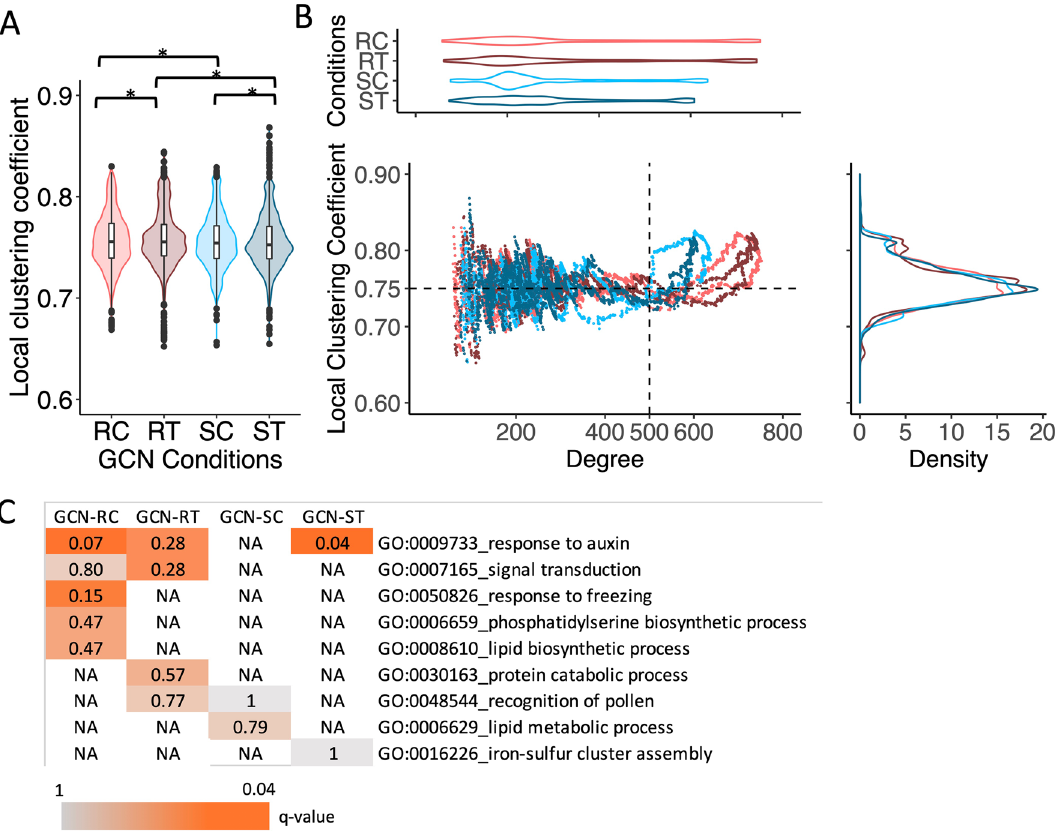
Figure 6. Demonstration of the hypothetical robustness based upon the cluster topology of Potato Virus Y (PVY) resistant and susceptible cultivars. ( A ) Violin plots showing the local clustering coefficient distribution of resistant and susceptible potato cultivars infected with PVY. Asterisks (*) indicate statistically significant differences based on the Wilcoxon rank-sum one-tailed test ( p -value < 0.05). The median local clustering coefficient of GCN-RC > GCN-RT, GCN-SC > GCN-ST, GCN-RC > GCN-SC and GCN-RT > GCN-ST. ( B ) Scatter plots showing the distribution of local properties of all nodes in the naïve networks; the x-axis in the scatter plot and violin plot represents the node degree, and the y-axis in the scatter plot and density plot represents the local clustering coefficient. ( C ) Heatmap showing the significance of GO enrichment (Q-value) of predominant genes in GCNs with high-degree nodes (degree > 500) and high clustering coefficients (c >